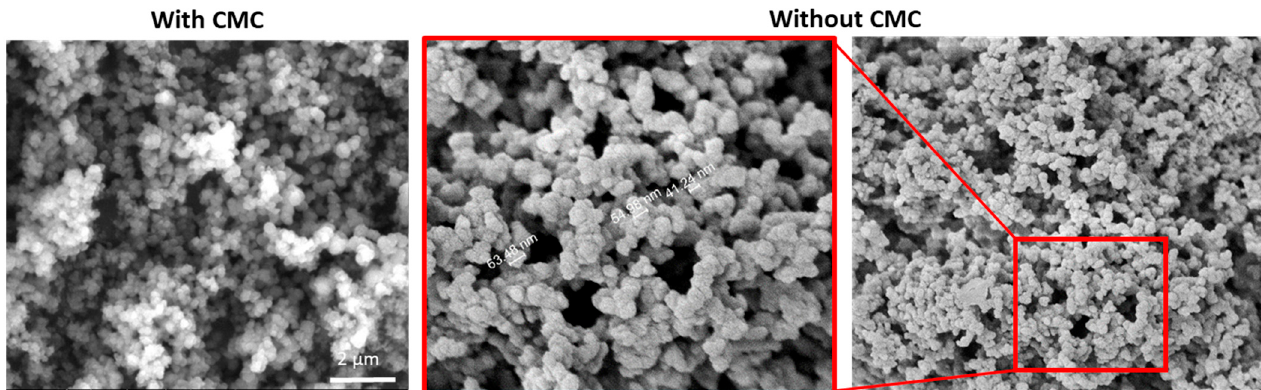
Figure 6. High-resolution SEM images of calcium carbonate particles produced with and without CMC. Nanospheres were obtained with the presence of silicate. Similar morphologies were obtained with or without the presence of CMC.